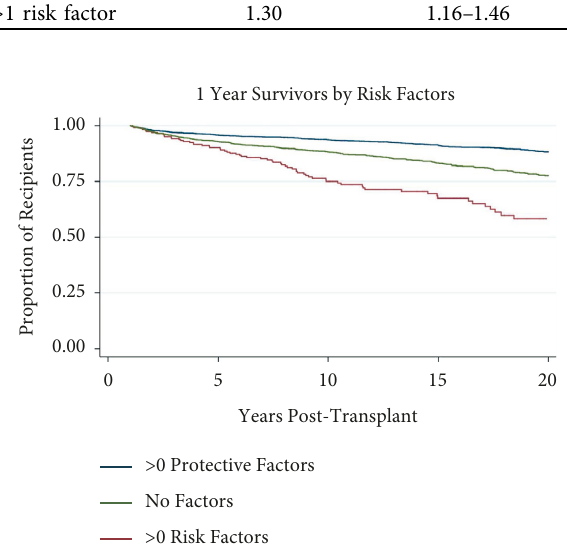
Figure 7: Kaplan–Meier survival function over time for 1-year survivor pediatric liver transplant recipients by risk